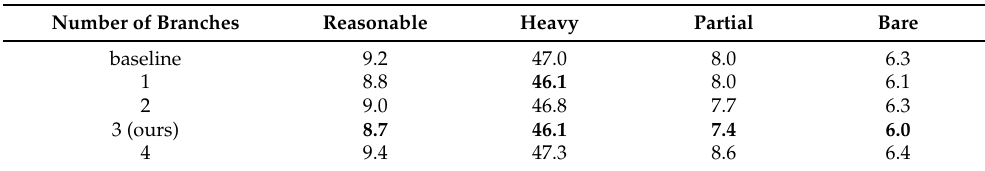
Figure 8. The eRF [52] of SMRF, TMRF and AMRF, which represent the actual responding area of a network structure over the input image. Table 7. The ablation experiments on the number of branches in the AMRF. The best results are highlighted in